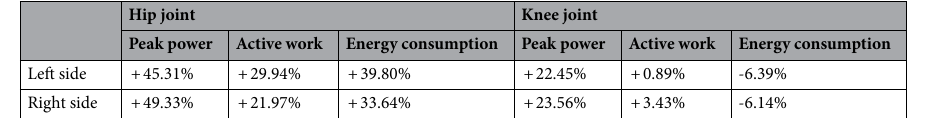
Table 6. Increasing rate of the optimized system parameters.